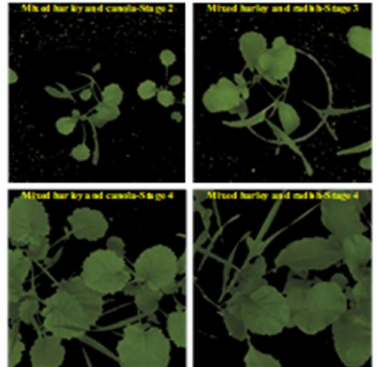
Figure 4. Barley was mixed with canola and wild radish at di ff erent growth